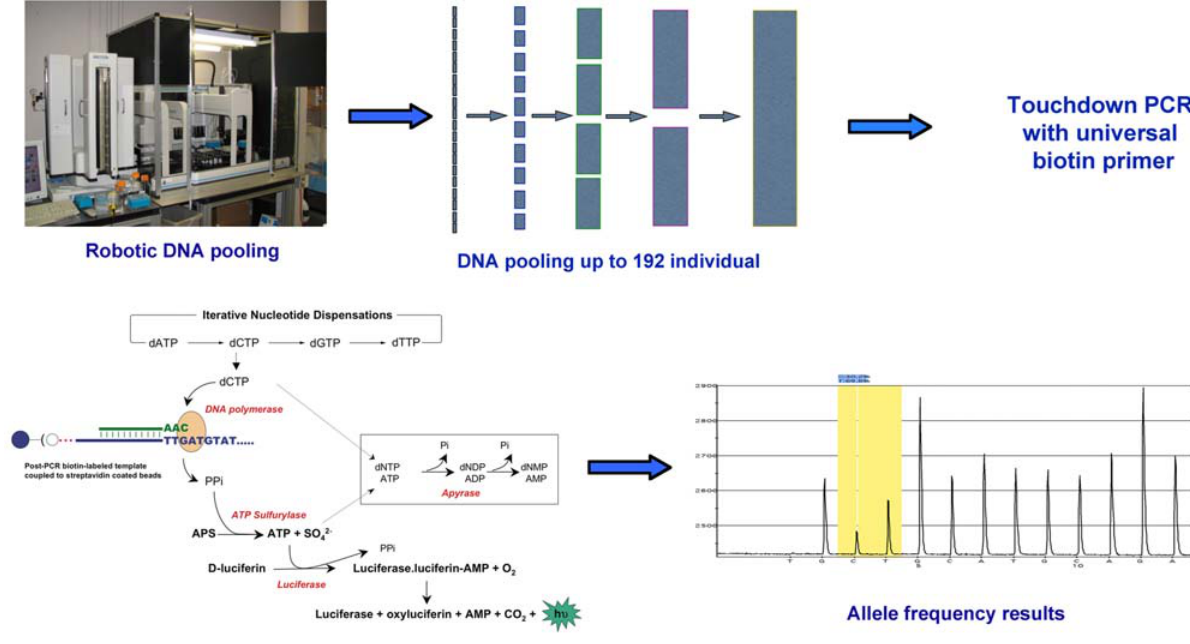
Figure 1. The overall workflow for high throughput allele frequency determination.